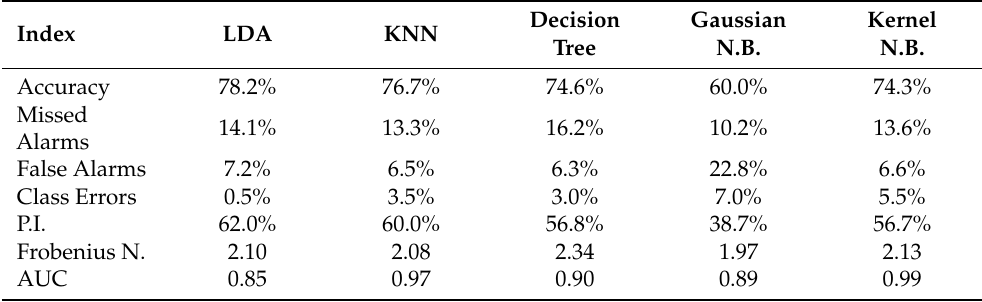
Table 2. Performance indices obtained with the most relevant k − 1 features calculated with tradi- tional